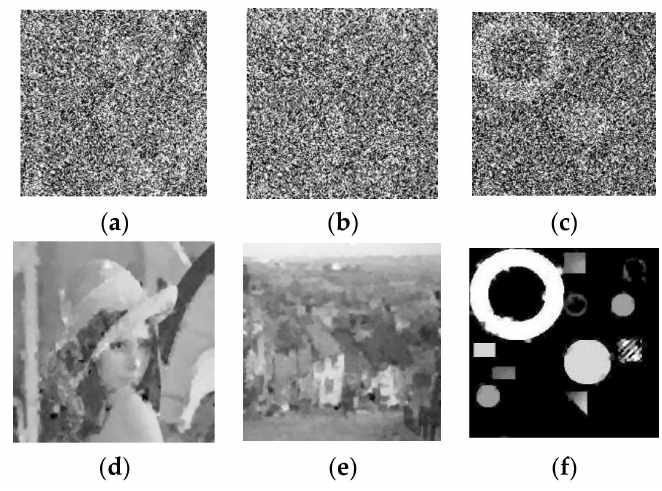
Figure 7. 30% wavelet coefficients are corrupted by salt-pepper noise and 10% coefficients are lost. ( a – c ) received images. ( d – f ) images reconstructed by TVL1.